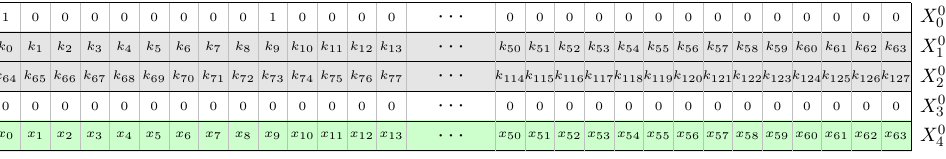
Figure 8: Initial state with cube variables in X 0